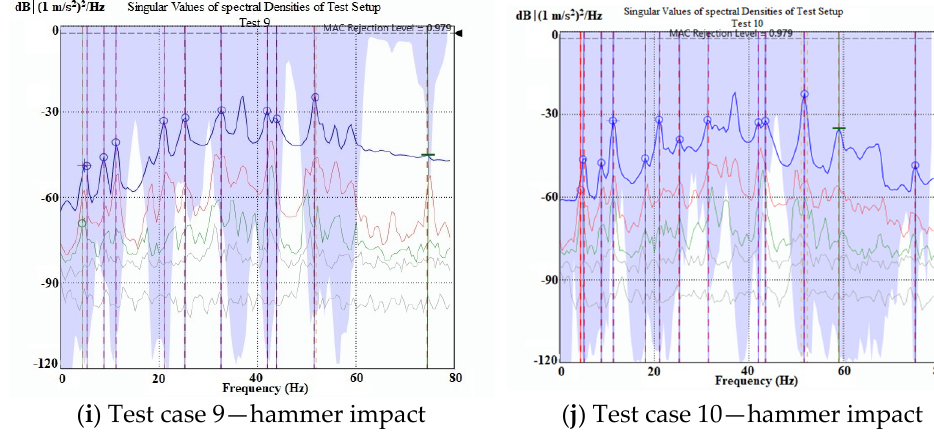
Figure 9. SVD of the acceleration response, along with identified frequencies. Table 2. Extracted natural frequencies using the EFDD method. Test Case